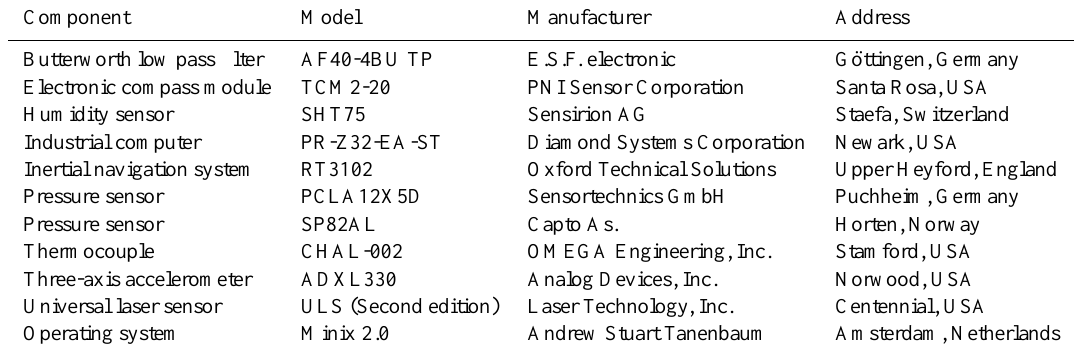
Table 1. Overview of sensors and electronic instrumentation used for the wind measurement.